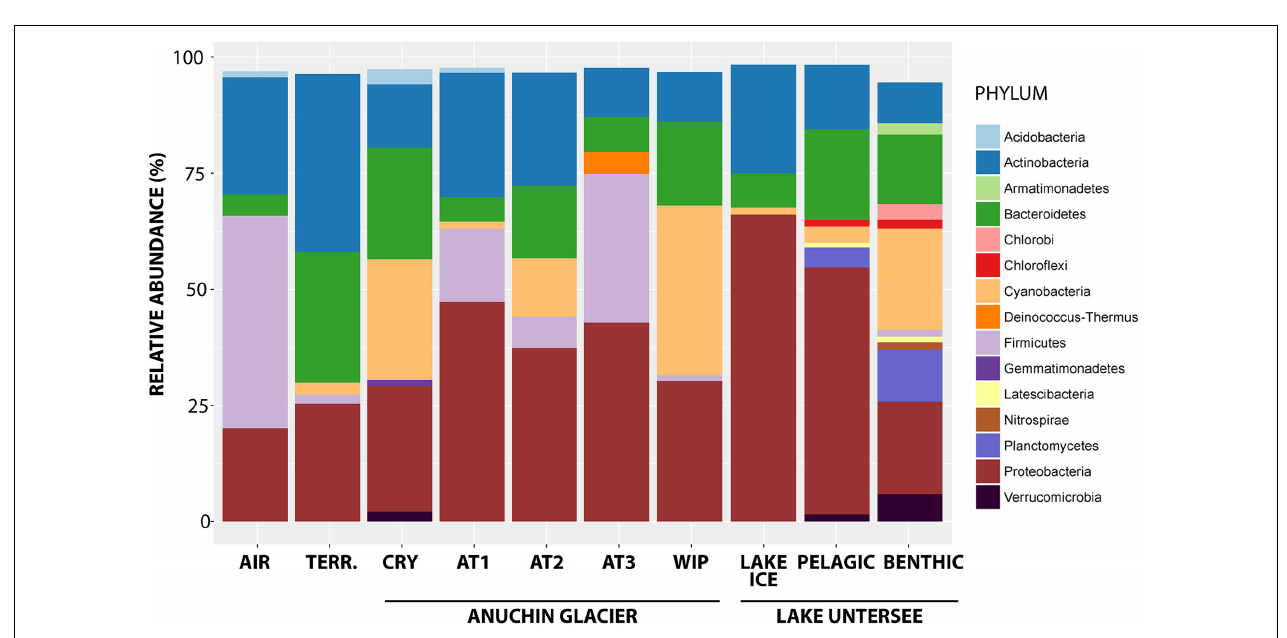
FIGURE 3 | The glacier-lake boundaries are shown for the years 1939 (blue), 1995 (red), and 2015 (yellow). Satellite image © DigitalGlobe, Inc. Provided by NGA Commercial Imagery Program.